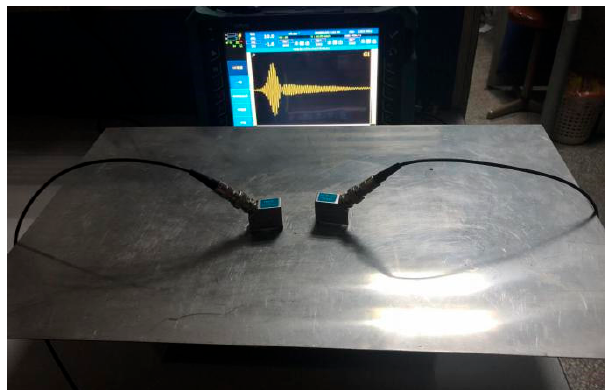
Figure 1. Experimental schematic.